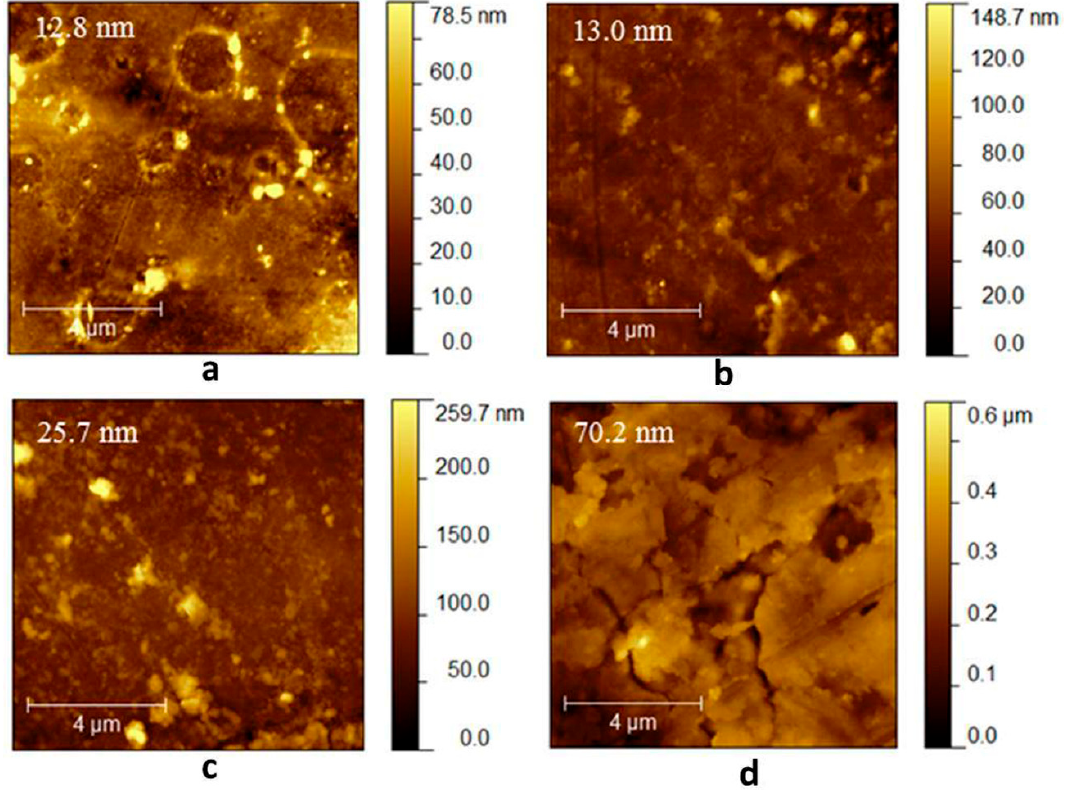
Figure 4. AFM topographic images for the duodenoscope samples: a —1st sample, b —2nd sample, c —3rd sample, d —4th sample.